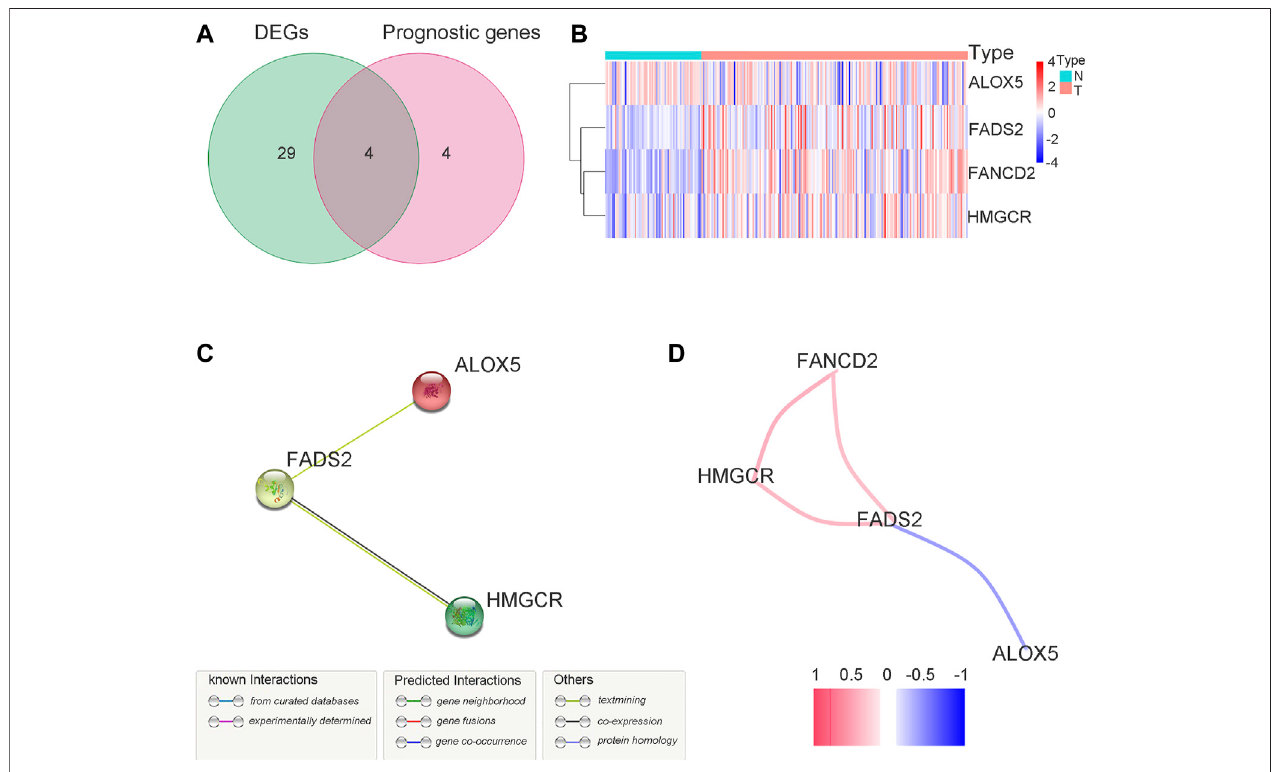
FIGURE 3 | Identi fi cation of the target ferroptosis-related genes during GEO cohort. (A) Venn diagram to identify prognostic DEGs in GEO cohort. (B) The expression pattern of candidate ferroptosis-related genes by heatmap. (C) The interactions between candidate genes with PPI analysis. (D) Connection network for candidate ferrotosis-related genes. Colors are utilized to present different correlation coef fi cients.